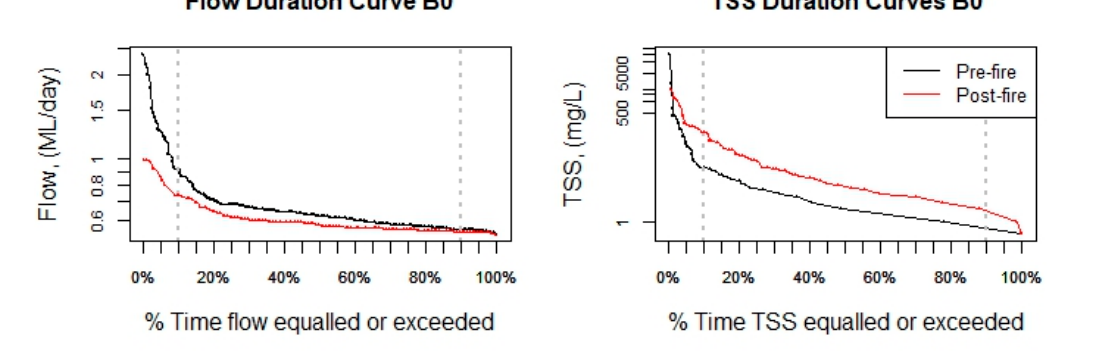
Figure 4. Duration curves for catchment C1. Abbreviations: C = Control; Q = Flow; TSS = Total Suspended Sediment; TN = Total nitrate; TP = Total phosphate.